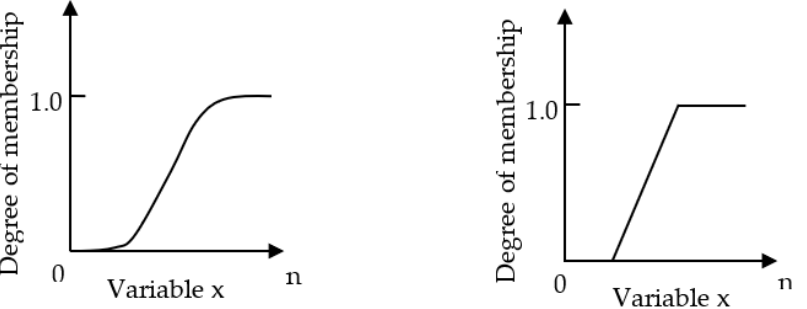
Figure 2. Typical fuzzy membership functions for a variable x: a smooth curve ( left ) and a linear function ( right ).